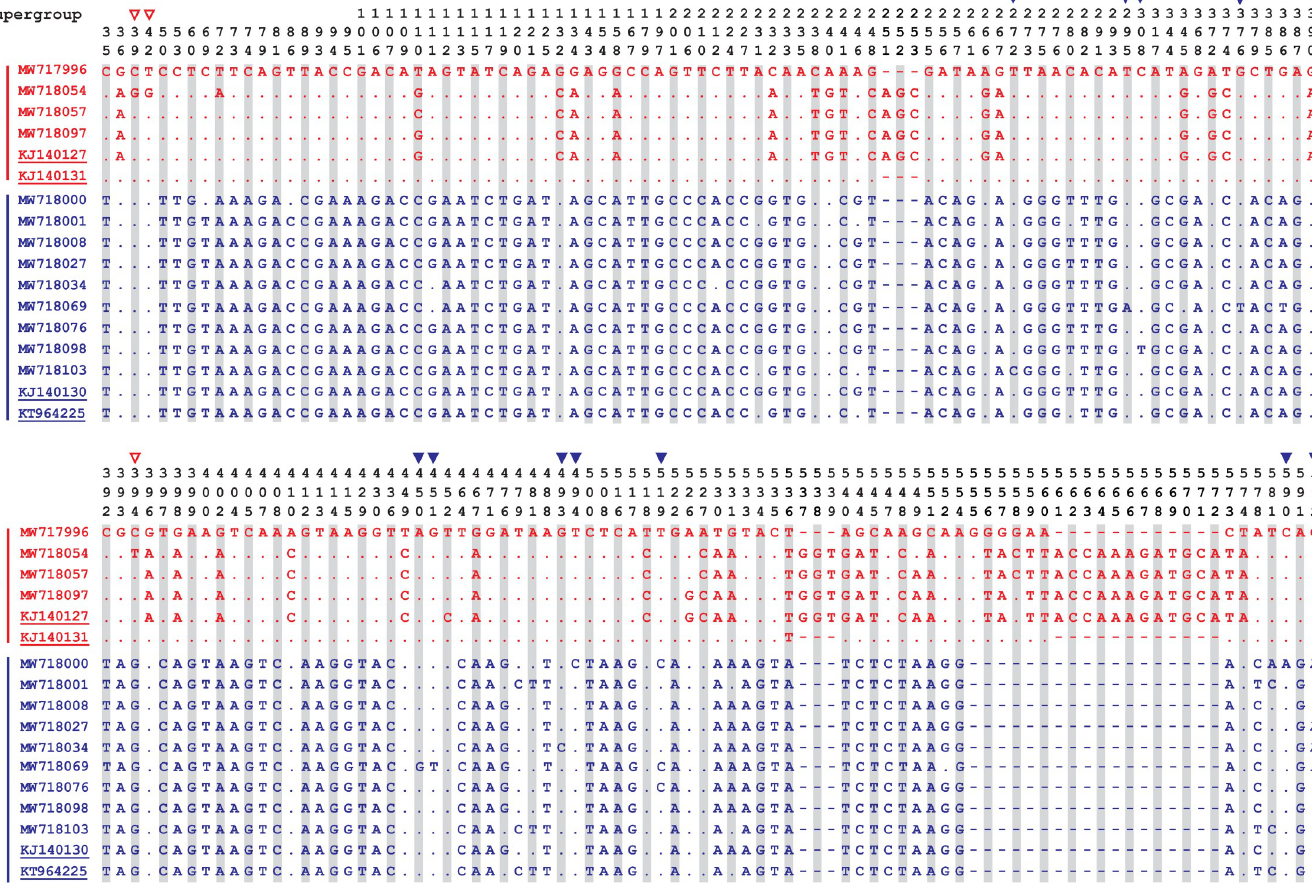
Fig 4. Alignment of partial-length of Wolbachia wsp gene nucleotide (~610 bp) sequences identified in this study (MW717996, MW718054, MW718057, MW718097, MW718000, MW718001, MW718008, MW718027, MW718034, MW718069, MW718076, MW718098, MW718103) together with 4 mostly identical reference sequences (KJ140127, KJ140131, KJ140130 and KT964225) obtained in GenBank database. Strains belonging to supergroup A and B are shown in red and blue, respectively, while the reference sequences are indicated with underlines. Numbers, read from top to bottom, above the sequences are nucleotide positions on the wsp gene of MW717996. Dots indicate nucleotides identical to the reference sequences. The triangles above nucleotide position numbers indicate sites of mutations in our isolates (supergroup A: 5 in red, and supergroup B: ▼ in blue) relative to the one or both of the reference sequences.